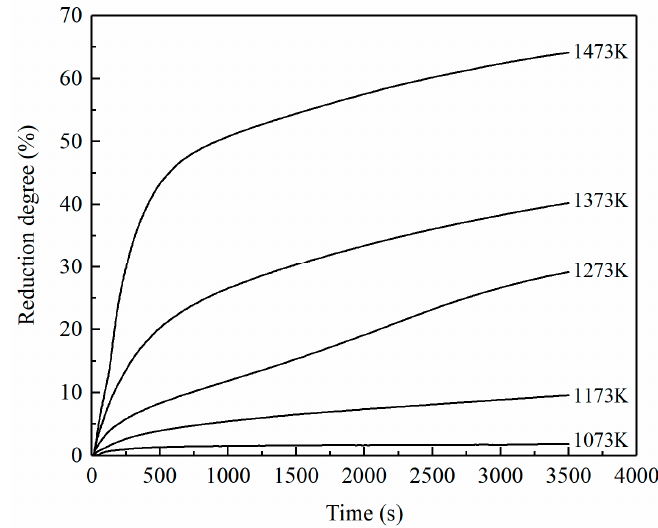
Figure 3. Reduction degree of Y1 as a function of reaction time [10].